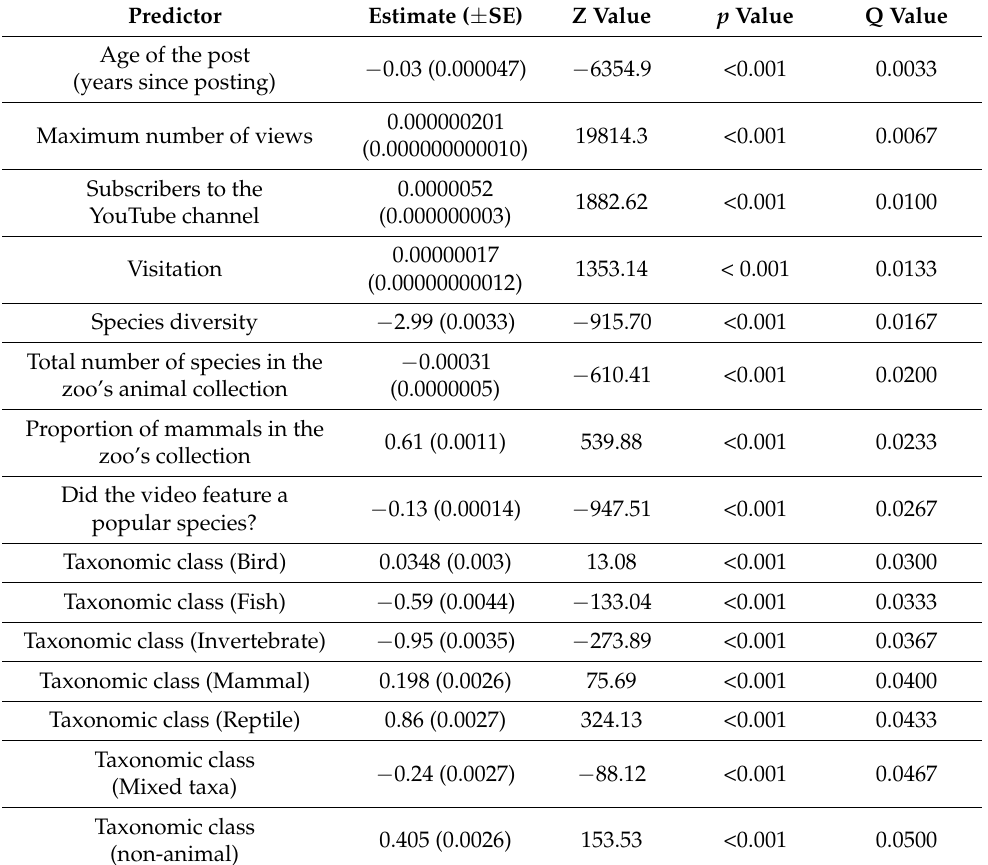
Table 4. Predictors of views, the output from a Poisson regression to determine the influence of key post and zoo characteristics on the number of views per year for all sampled posts from the 20 zoo-YouTube